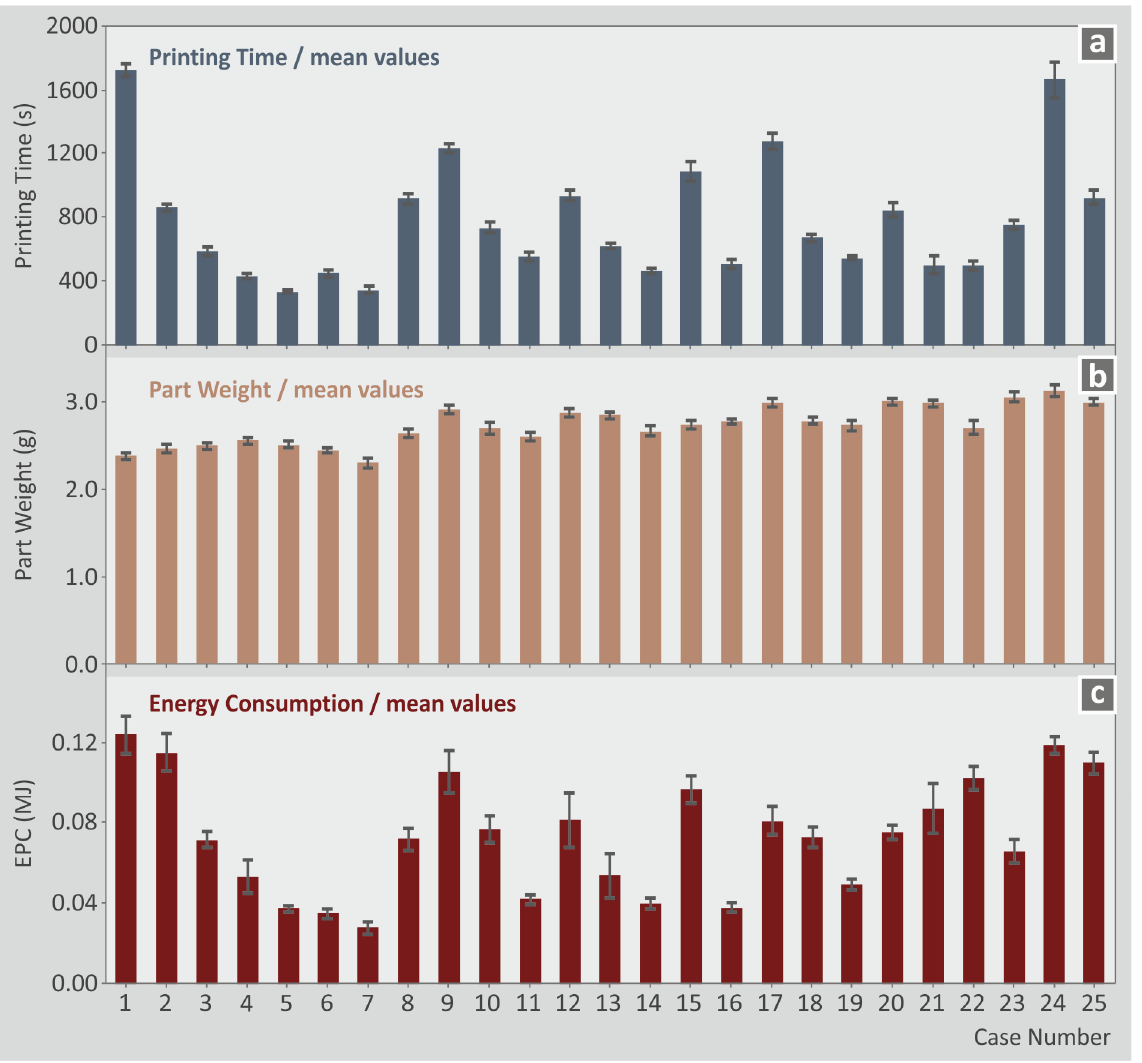
Figure 5. Experimental results mean values and deviation for three metrics (for the twenty-five runs) ( a ) printing time (s), ( b ) part weight (g), ( c ) EPC (MJ).